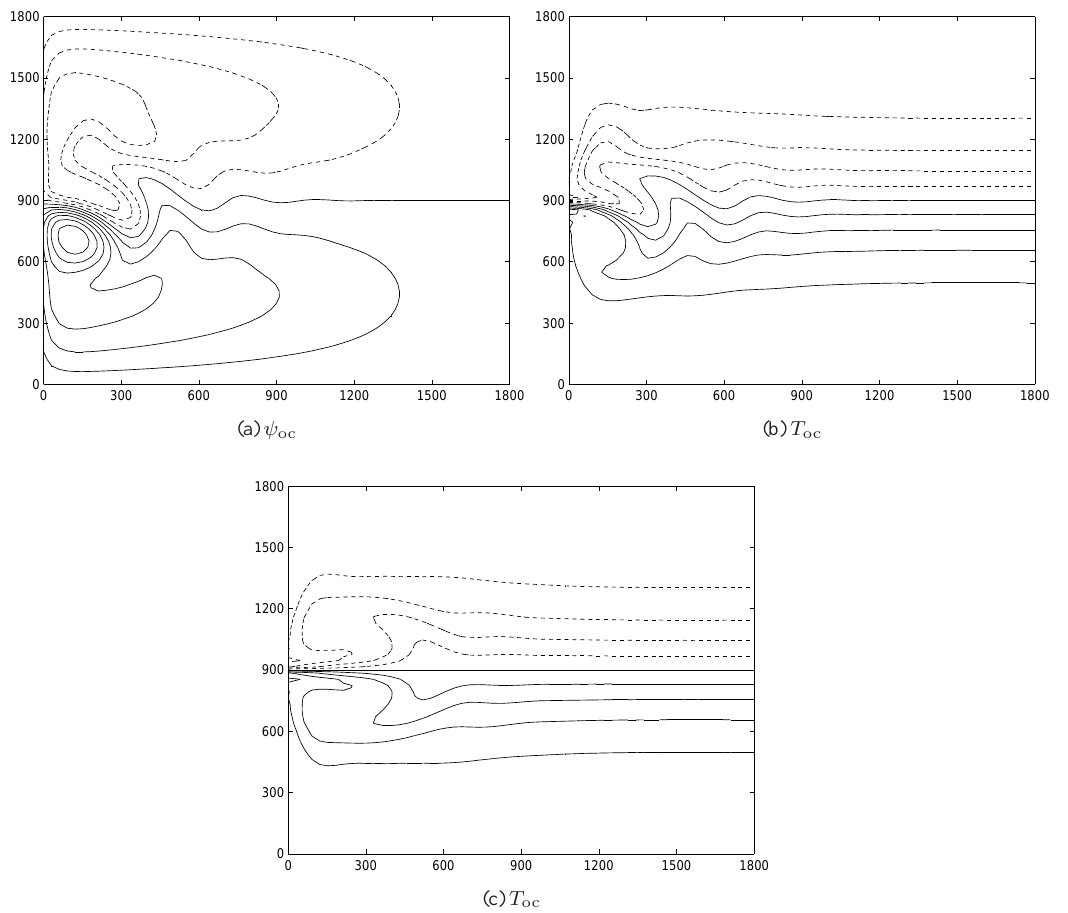
Fig. 3: (a,b) An asymmetric steady-state solution just below the first Hopf bifurcation H ′ 1 , with with contours every 2 × 10 − 2 ; stream function contours in non-dimensional units, here and in similar figures. (b) SST field; contours σ = 0 . 78 . (a) Stream function ψ oc ( x,y ) , with contours every 2 × 10 − 2 ; stream function contours in nondimensional units, here and in similar figures. (b) SST field; contours every 2 K. (c) Antisym- metric SST field for the same value of σ . Here and in the following, positive contours are solid, negative contours are dashed.